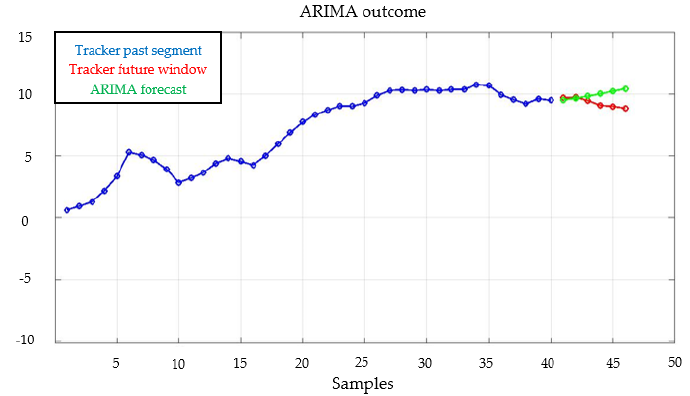
Figure 11. Algorithm’s forecast (green line) against real tracker behavior (red line), in the case of nominal operative conditions (sample 83 of tracker time series).